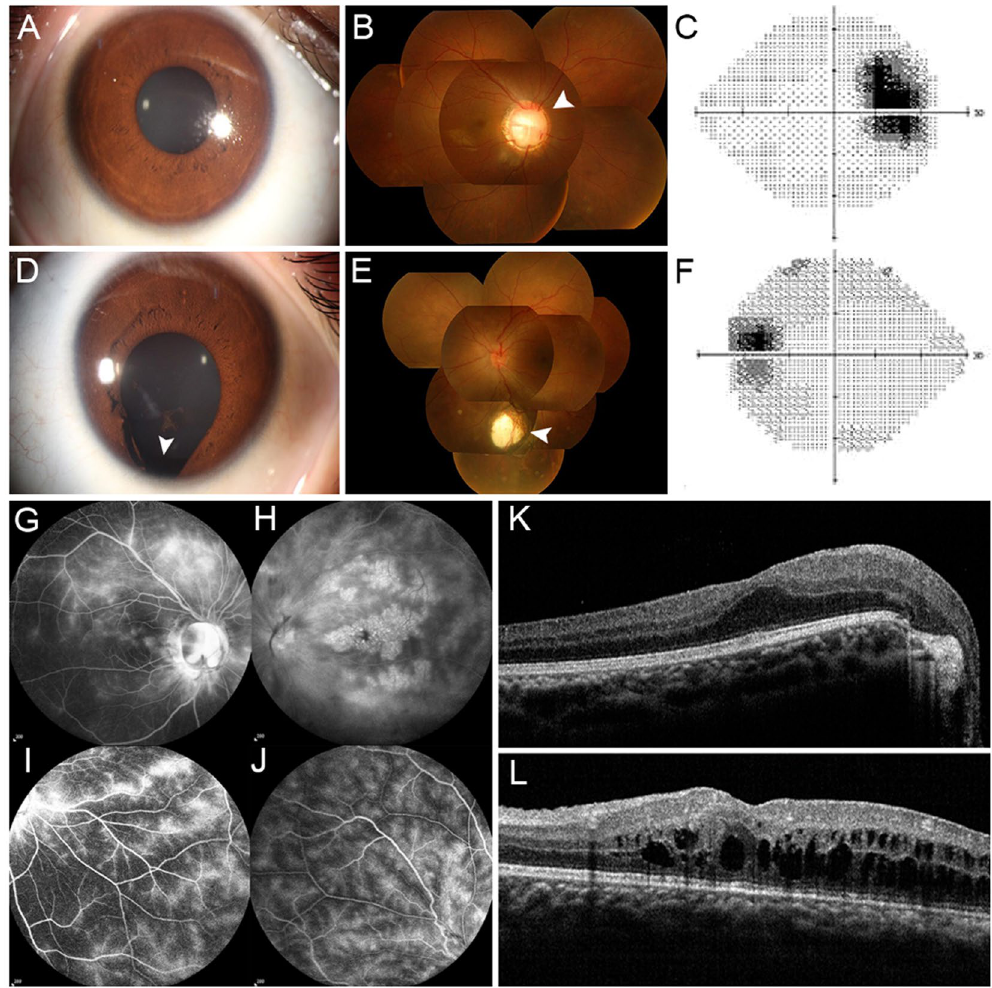
Figure 1. Clinical features of the patient with RAX mutation. ( A and D ) Representative photographs of the anterior segments. ( A ) The normally-performing right eye. ( D ) The left eye presented with iris coloboma located inferiorly (as indicated by the white arrow). ( B and E ) Fundus photographs showed optic disc coloboma in right fundus (white arrow) and choroid coloboma in the left fundus (white arrow). ( C and F ) Visual field test demonstrates a physiological blind spot and low visual contrast in the right eye. ( G – J ) FFA images revealed leakage of fluorescein from the macular and peripheral retinal telangiectatic vessels in both eyes with different degrees. ( K and L ) Spectral-domain optical coherence tomographic and visual field test. ( K ) Macular edema in the right eye. ( L ) Macular edema and retinoschisis in the left